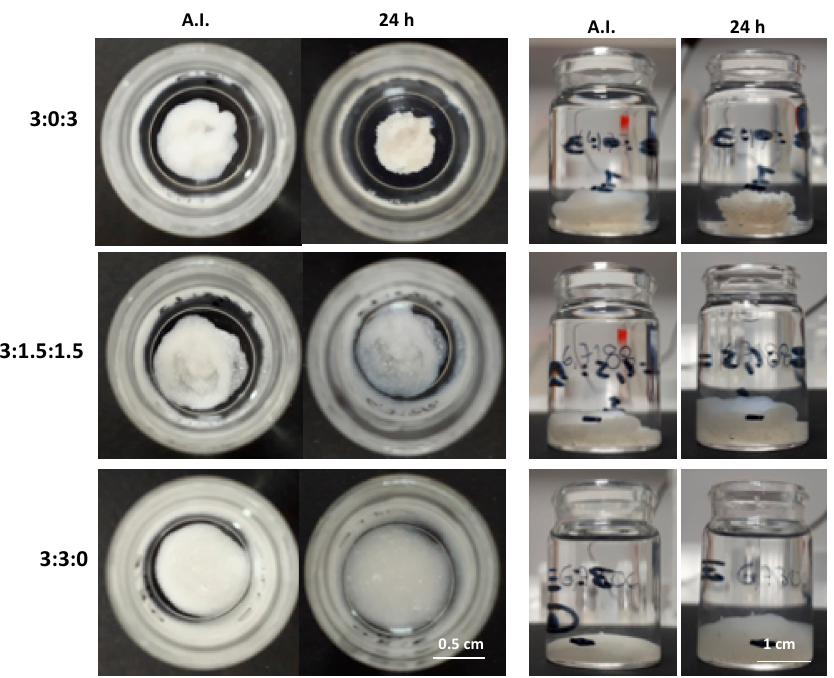
Figure 7. Qualitative evaluation of the integrity and self-healing properties of CHT:PCDi:PCDs hydrogels after injection with an 18G needle in PBS at 37 °C: Immediately after injection (AI) and after 1 h and 24 h of incubation.